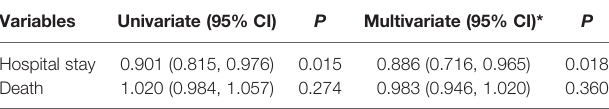
TABLE 3 | Associations between serum IL-37 and CAP severity scores among CAP patients. Variables